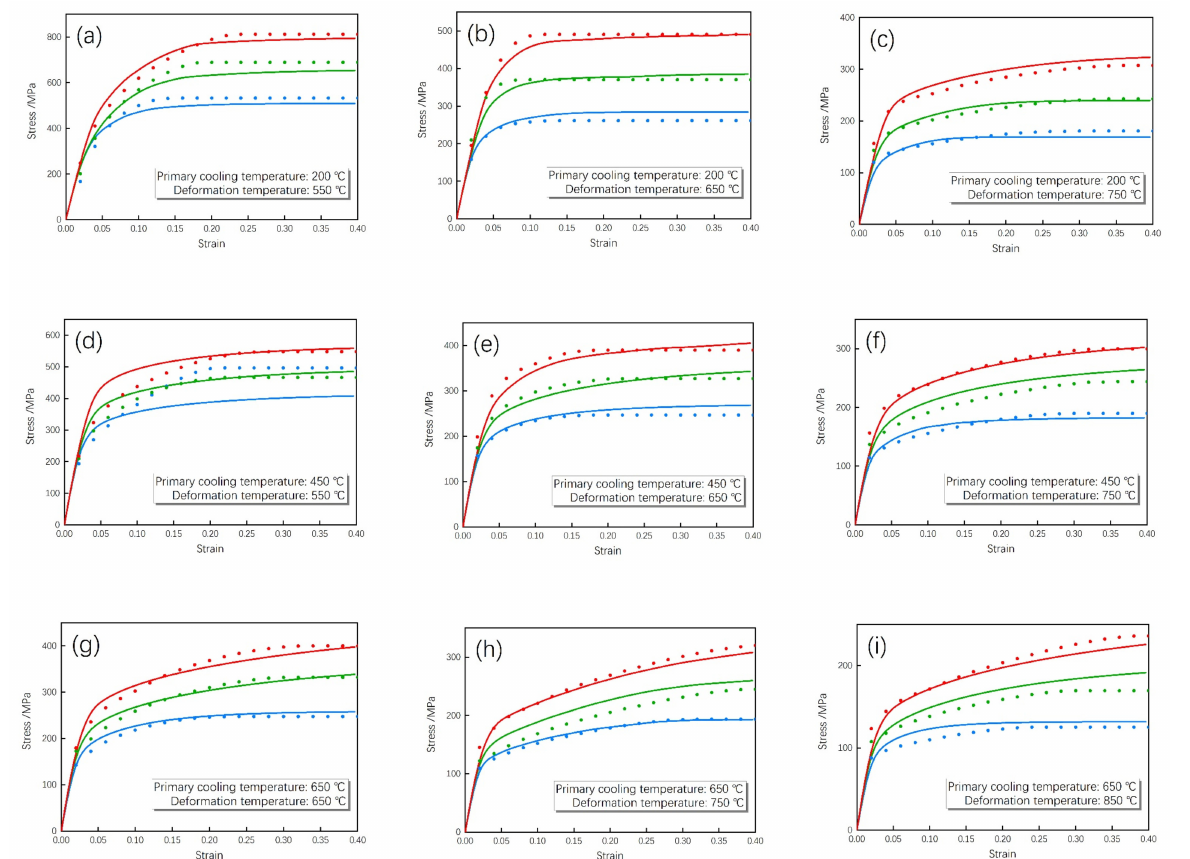
Figure 9. Comparison of experimental and calculated strain-stress curves at different primary cooling temperatures, deformation temperatures and strain rates. Blue, green and red colors represent the strain rate of 0.01 s − 1 , 0.1 s − 1 , 1 s − 1 . Primary cooling at 200 ◦ C, deformation at ( a ) 550 ◦ C, ( b ) 650 ◦ C, ( c ) 750 ◦ C, primary cooling at 450 ◦ C, deformation at ( d ) 550 ◦ C, ( e ) 650 ◦ C,( f ) 750 ◦ C, primary cooling